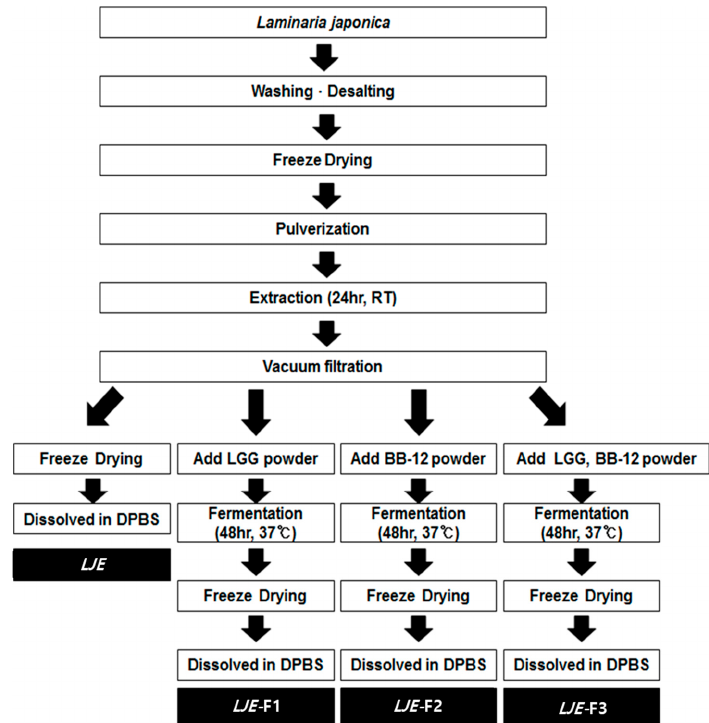
Figure 1. A flow diagram of Laminaria japonica (LJ) water extract (LJE) and fermented LJ water extract (LJE-F1, -2, and -3) preparation. Abbreviations: LGG; Lactobacillus rhamnosus LGG, BB-12; Bifidobacterium animalis ssp. lactis BB-12; DPBS, Dulbecco’s phosphate-buffered saline; and RT, room temperature.